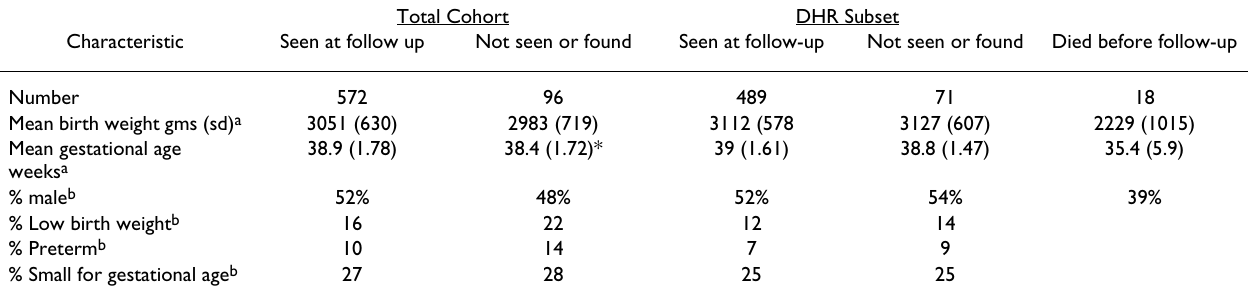
Table 4: Characteristics of children according to seen and not seen status at time of follow up. Aboriginal Birth Cohort Study 1998–2001